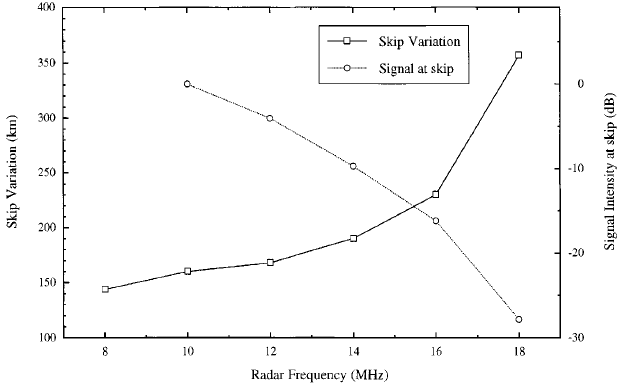
Fig. 9. The modelled skip variation and signal power returned from ranges within 90 km of the skip as a function of